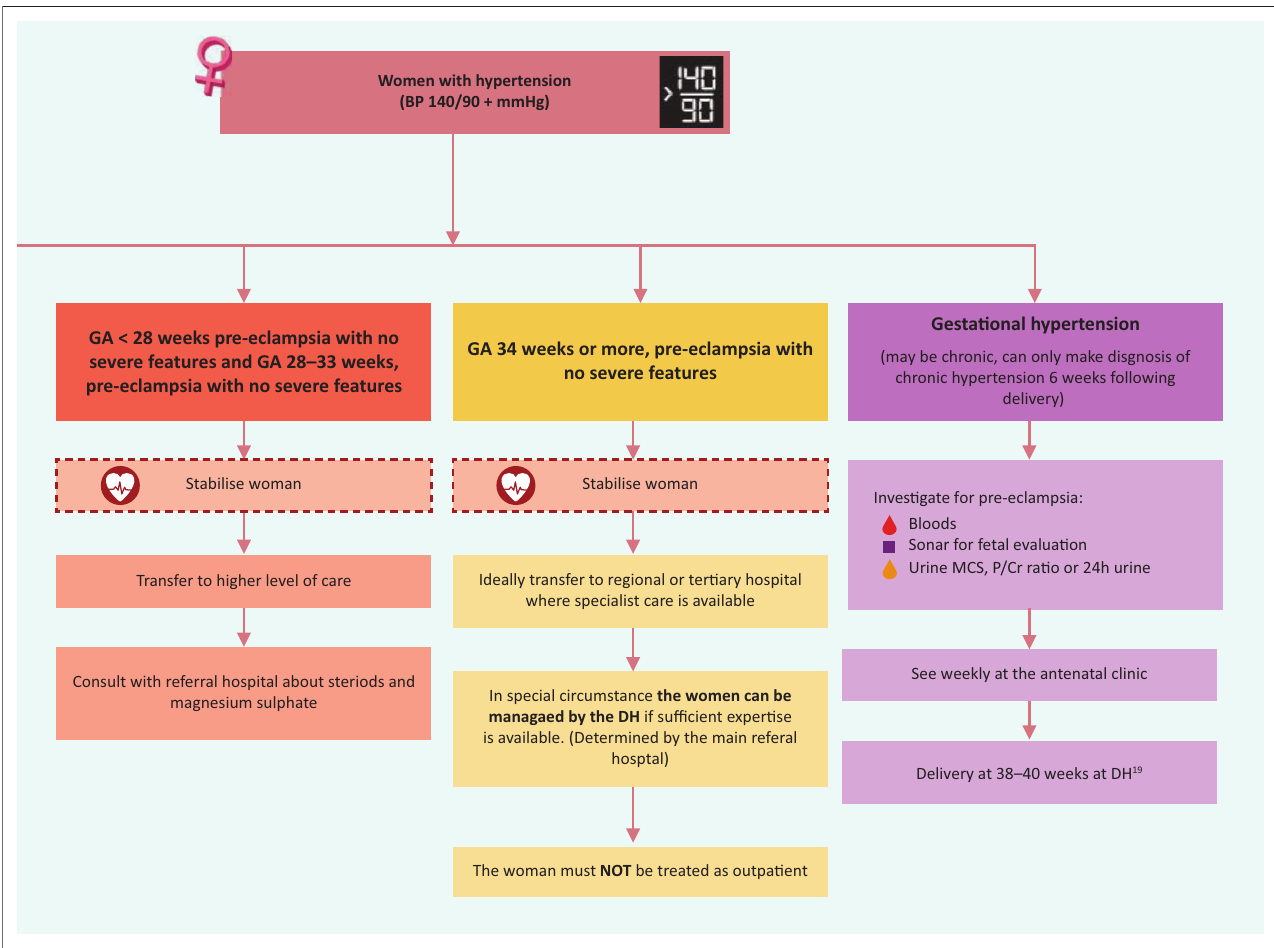
Inves(cid:26)gate for